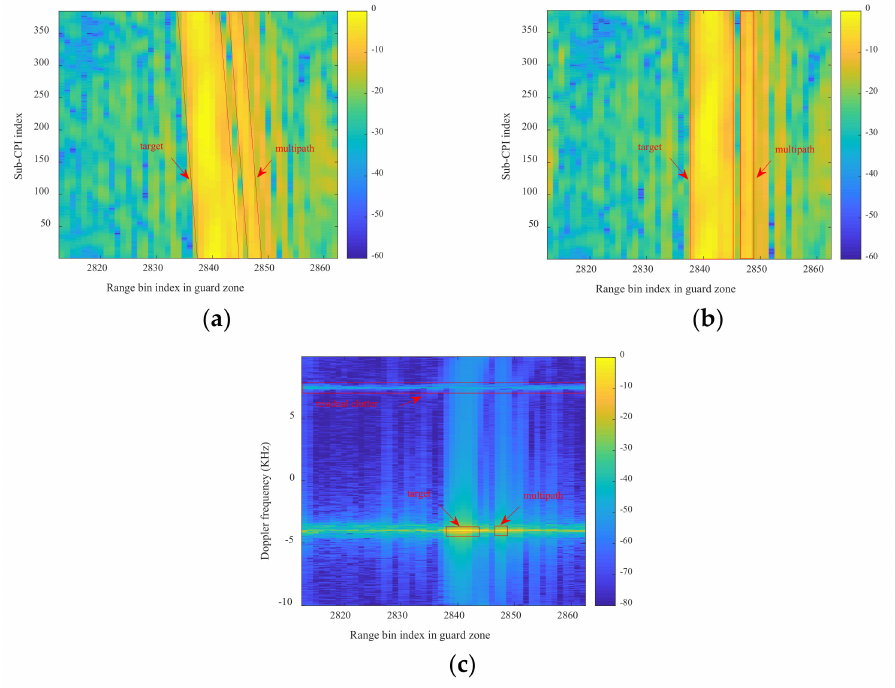
Figure 9. Experiment results of joint multi-resolution STAP. ( a ) R-D specified full-band Σ∆ -STAP outputs. ( b ) RW correction result. ( c ) Further coherent accumulation result.